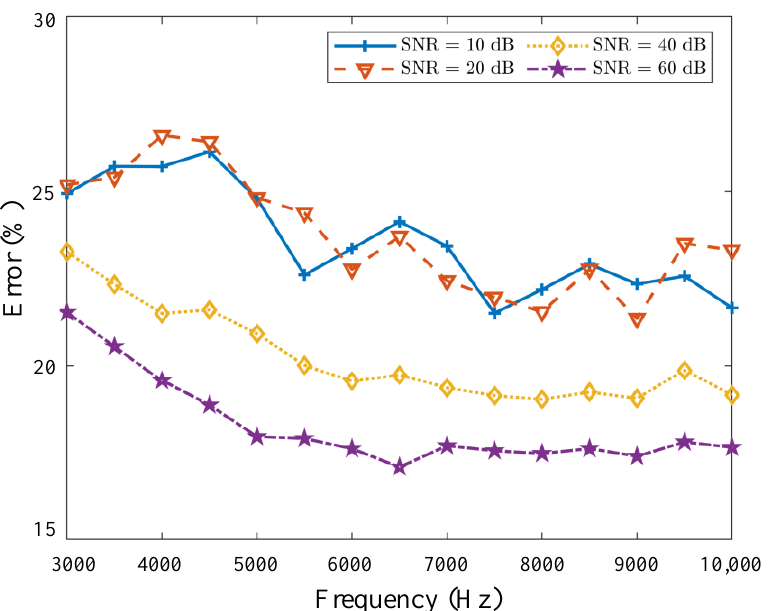
Figure 15. The relative error of the spectral matrix completion (S com ) and the full spectral matrix (S Full ) with di ff erent frequencies and di ff erent signal-to-noise ratios (SNRs).